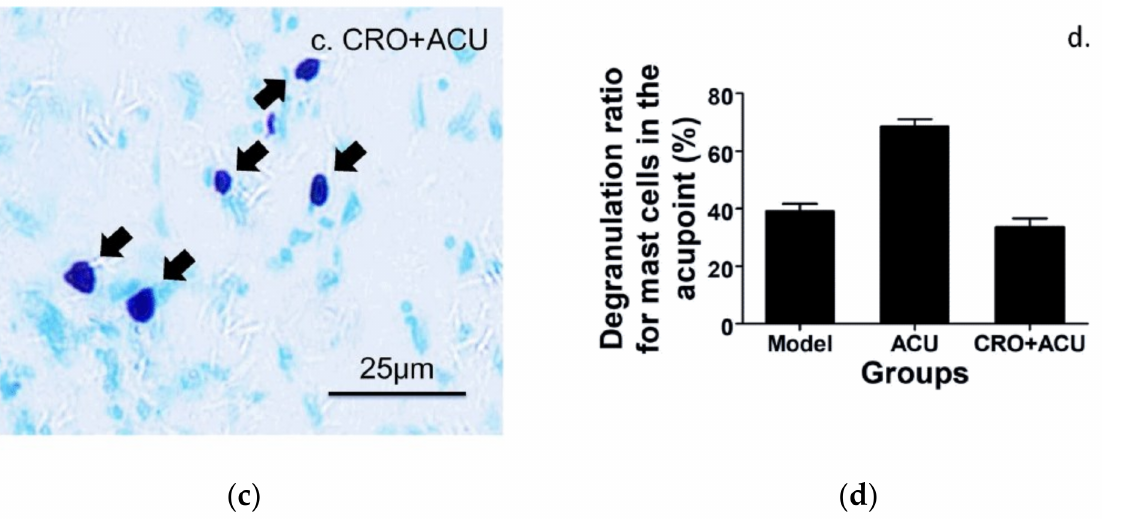
Figure 5. The degranulation of MCs at ST36 induced by acupuncture. ( a – c ) Paraffin sections prepared from ST36 of different groups. Inflammation pain was established by injection of 50 µ L Complete Freund’s Adjuvant (CFA) into the left ankle joint cavity to induce acute adjuvant arthritis after rat was anesthetized with 1.5% isoflurane. Inflammatory syndrome, local swelling and behavioral disability appeared within 24 h. Two days later, ipsilateral AP treatment (20 min) was performed on left acupoint ST36. Contained MCs were labeled with toluidine blue. CRO (0.02 g/mL, 20 µ L) was pre-injected in treated acupoints 20 min before needling. The dark arrows point to intact MCs and the hollow arrows point to degranulated MCs. ( d ) Comparison of the degranulation ratio of MCs in ST36 from different groups. Figure is from Huang et al. (2018) [32],with permission from Springer Nature. Moreover, a function test confirm that MC degranulation is an essential step towards an analgesic effect of acupuncture. The ankle AA rats benefit from acupuncture at ST36. However, using CRO to shield the degranulation of MCs in the treated acupoint can significantly weaken the acupuncture analgesic effect [31,32] (Figure 6a). The underly- ing mechanism might be upregulation of β -endorphin level in the cerebrospinal fluid (Figure 6b)